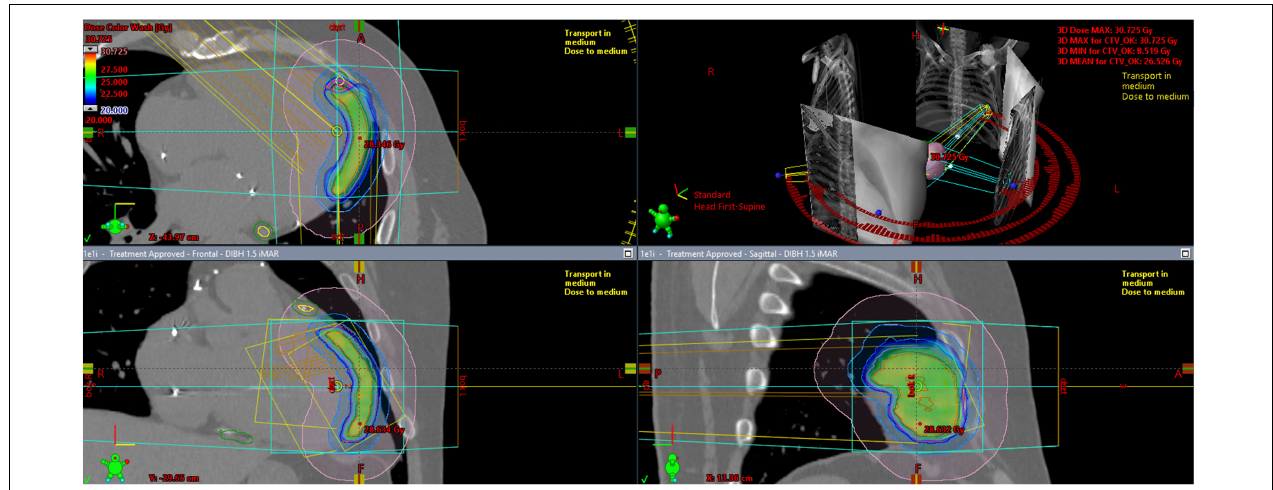
FIGURE 3 | Color-wash representation of the dose distribution within the irradiated heart, ranging from 20 Gy (blue) up to a maximum dose of 30.7 Gy (red). The coronary artery sparing is well-visible in the upper part of the upper-left sagittal projection.